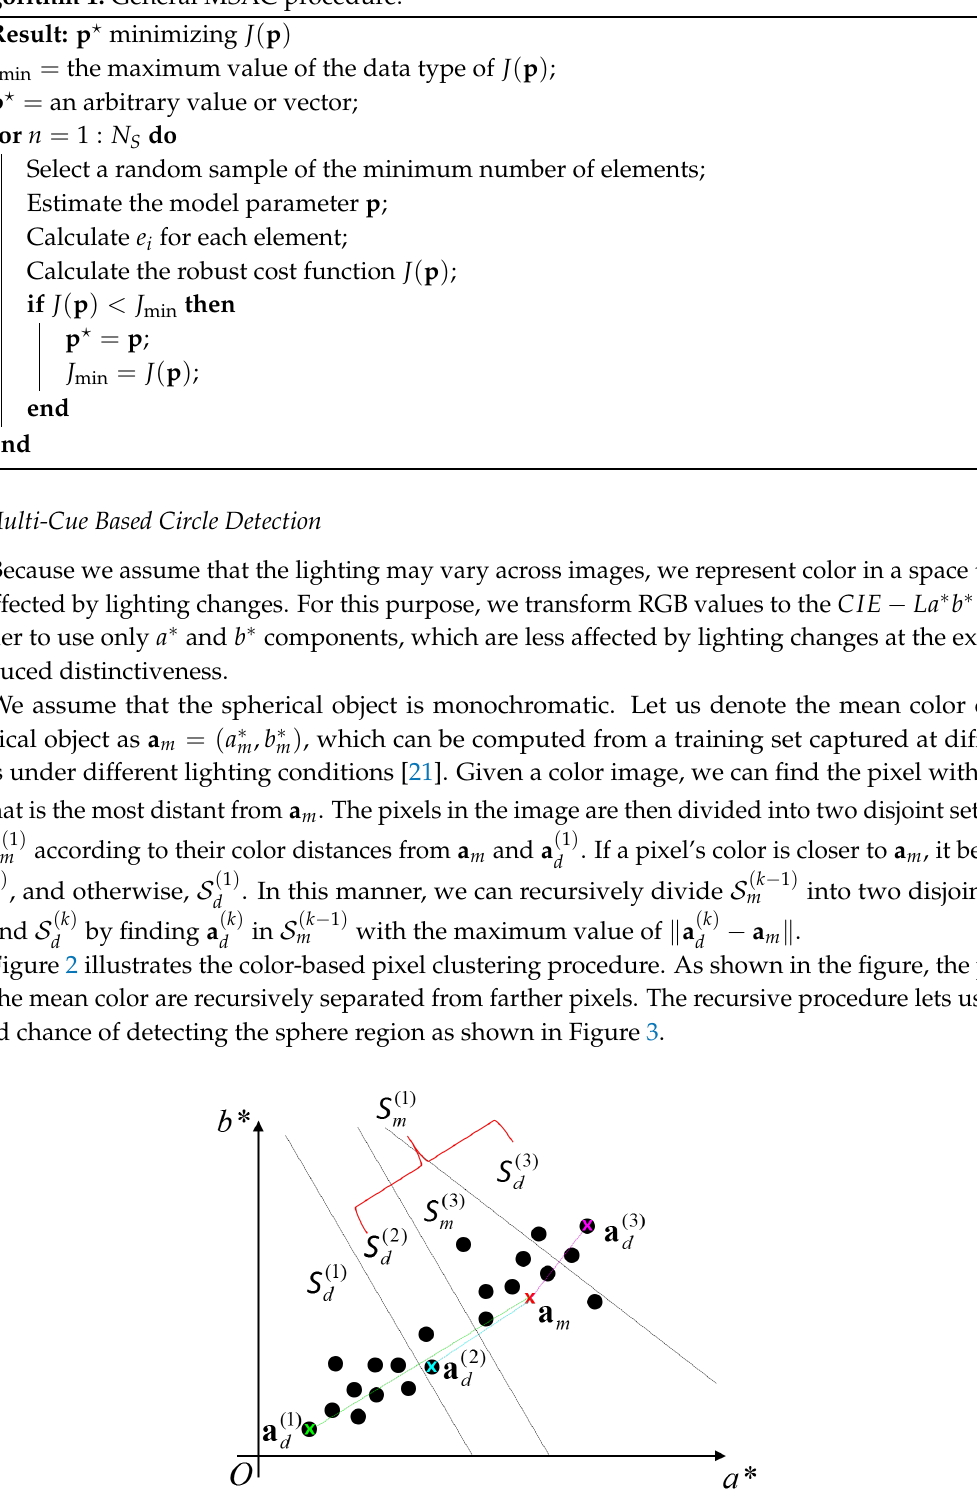
Algorithm 1: General MSAC procedure.